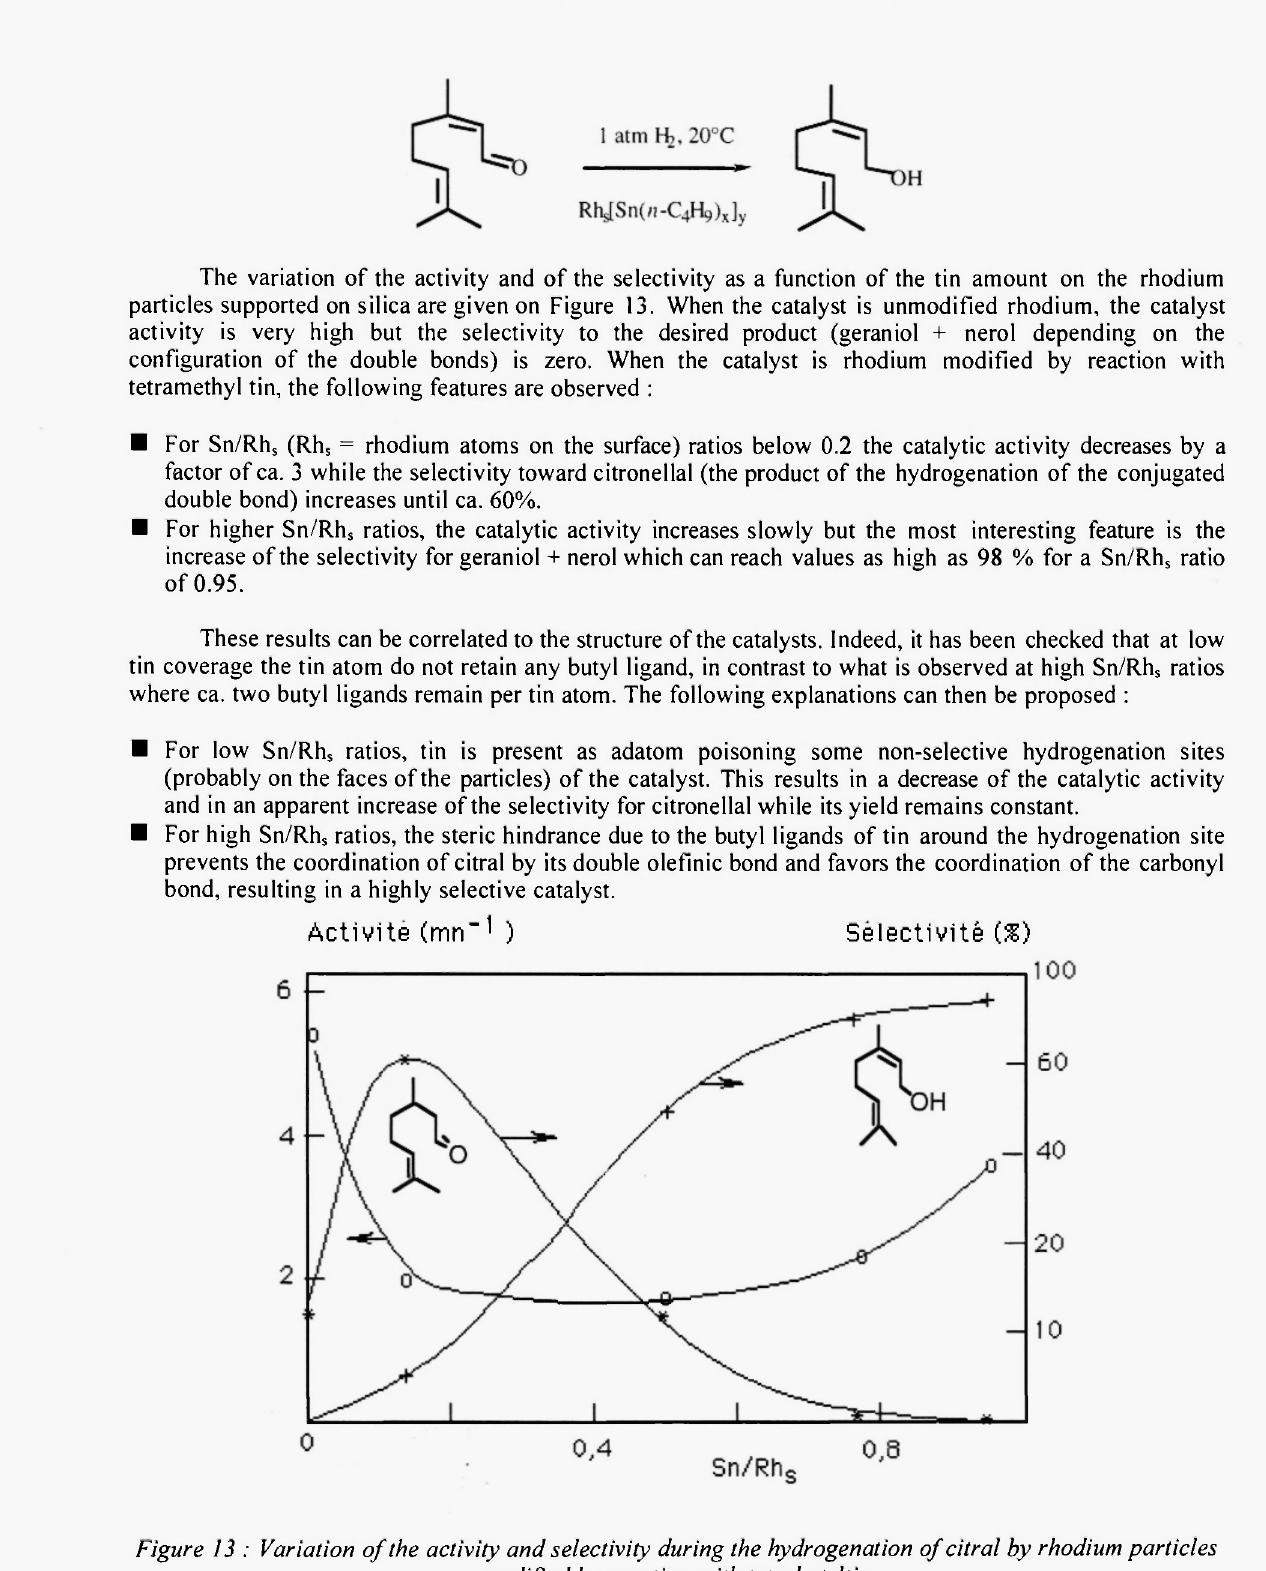
Figure 13 : Variation of the activity and selectivity during the hydrogenation of citral by rhodium particles modified by reaction with